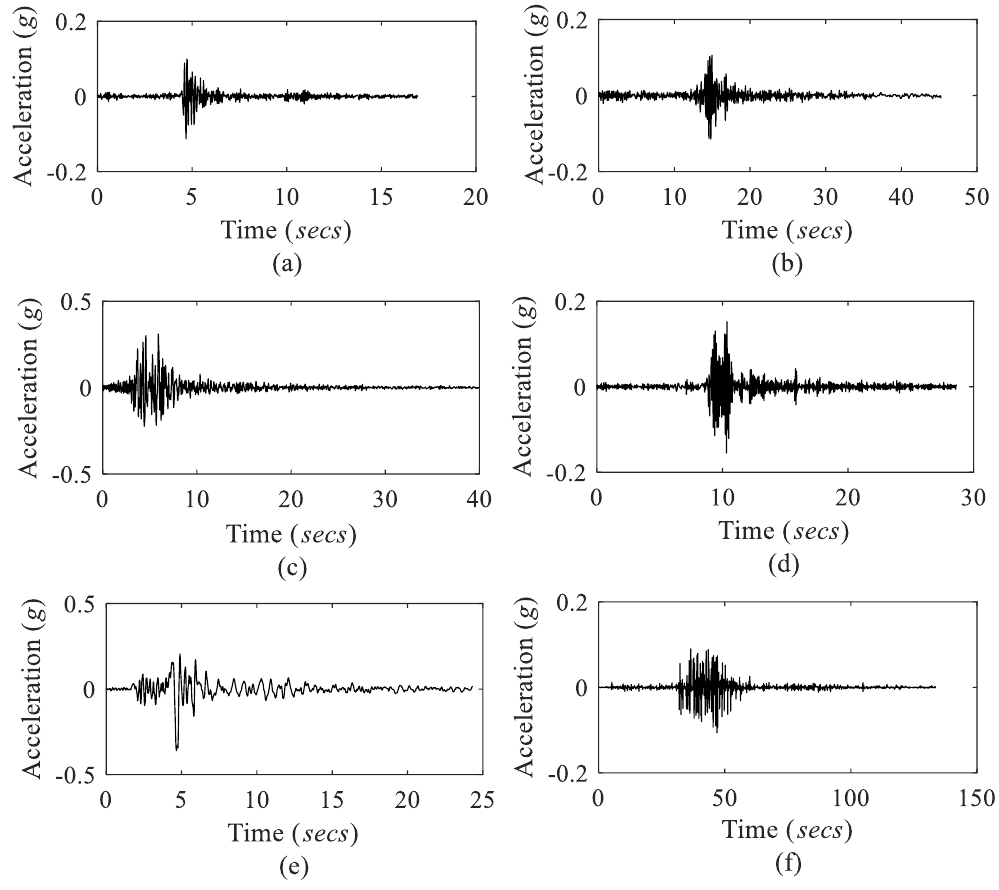
Fig. 7. Ground acceleration used in present work (a) NE-India earthquake (b) India-Bangladesh Border earthquake (c) Uttarkashi earthquake (d) India-Burma Border earthquake (e) Chamoli earthquake (f) Bhuj earthquake. Earthquakes considered for present